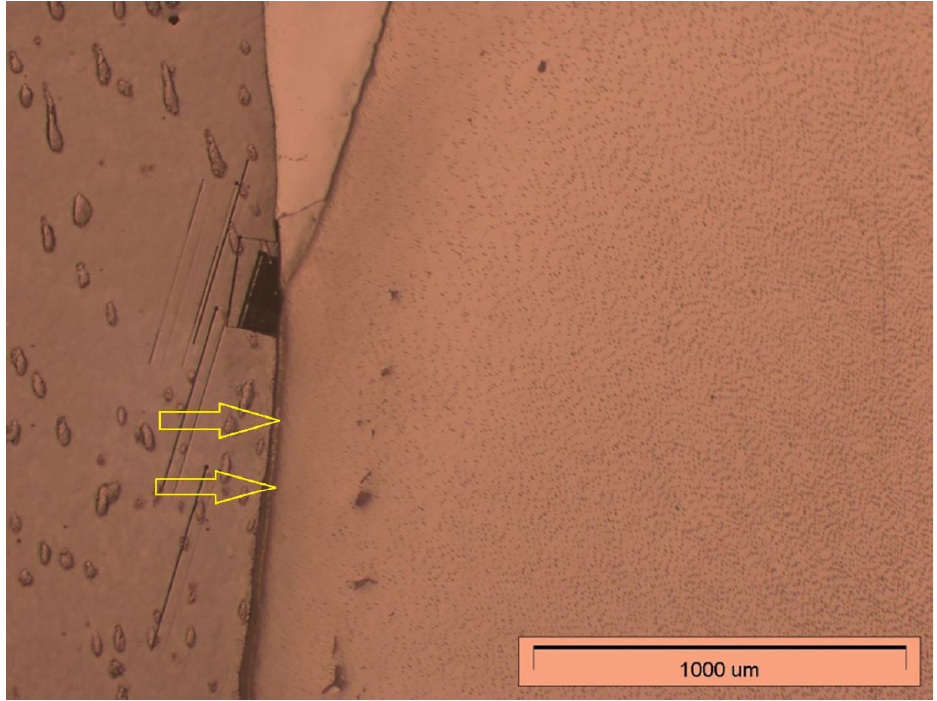
Figure 6. Visible penetration of the experimental preparation in the cervical area of a tooth. The arrows indicate the direction of penetration.